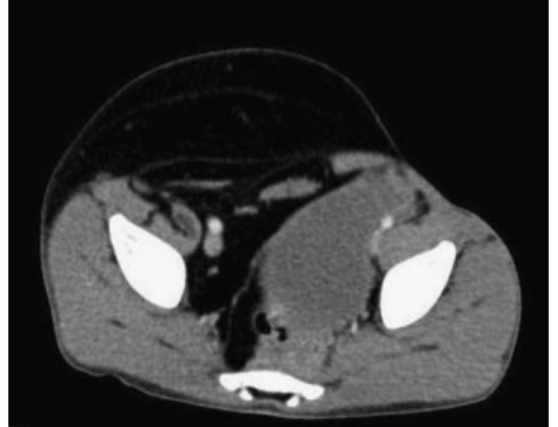
Fig. 1 Abdominal magnetic resonance imaging revealed a giant hypodense lesion, stretching from the inferior of the liver to the inguinal region covering the right kidney and the right ureter.